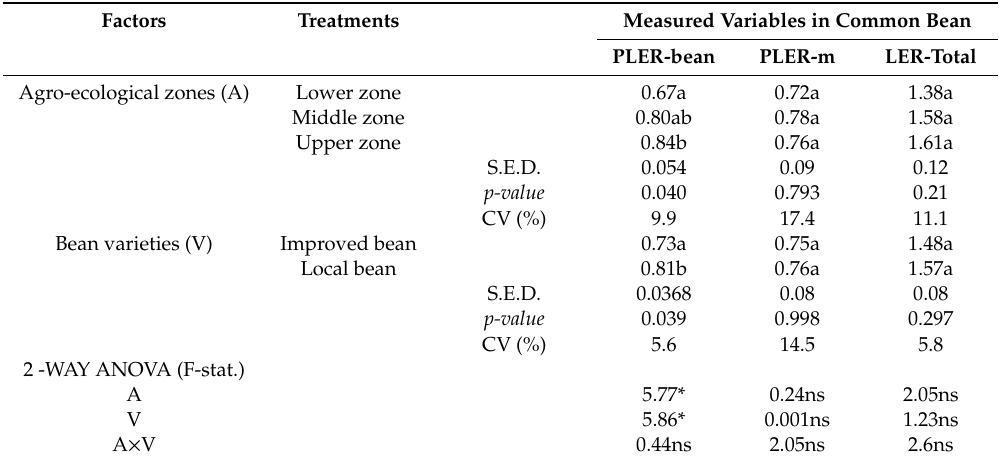
Table 3. Partial and total land equivalent ratios (PLER and LER) of maize and two varieties of common bean measured in di ff erent agro-ecological zones.